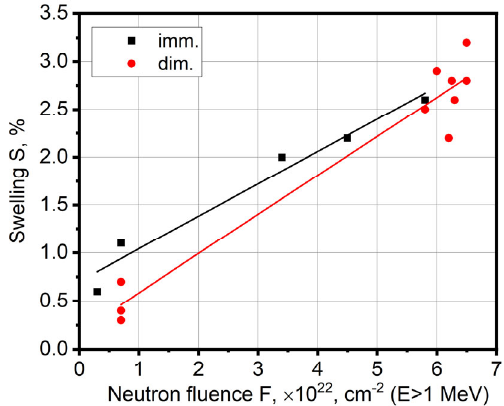
Figure 5. Dose dependence of swelling S of HE-56 beryllium grade, reactor SM-3, T irr = 200 ◦ C, F = (0.3–6.5) · 10 22 cm − 2 (E > 1 MeV) (imm.—immersion, dim.—dimension).